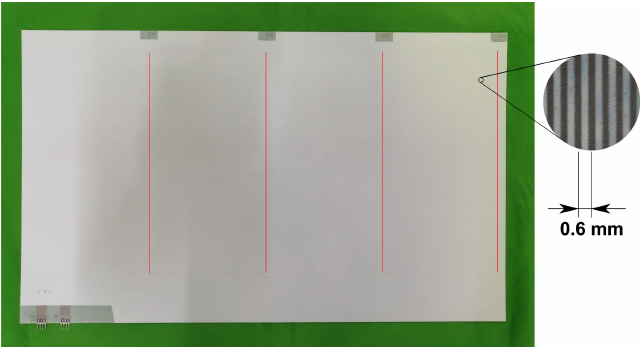
Figure 10. The stator of the electrostatic actuator used in the experiment. The white rectangle is the stator sheet. Although not visible due to the opaque insulation layer, the stator sheet contains four-phase parallel electrodes with an electrode pitch of 0.6 mm, which is shown in the enlarged picture on the right. Four sensing electrodes are arranged at the locations shown by red lines. The red lines were drawn in the photo for explanation purposes.